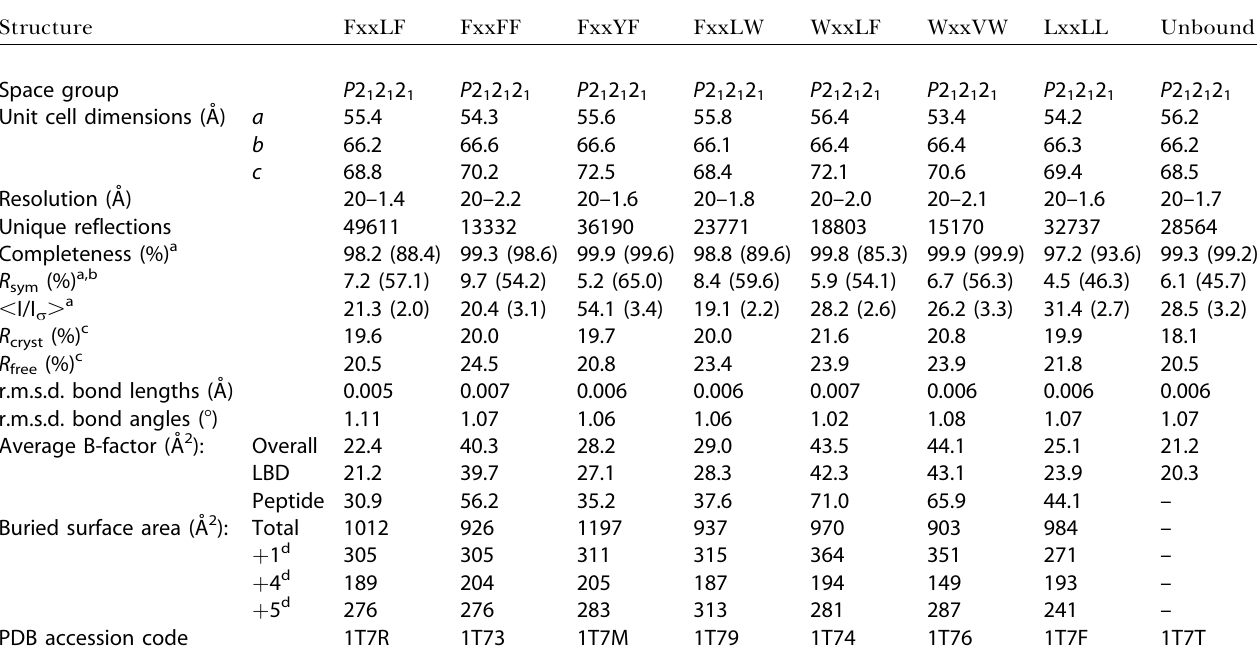
Table 2. Summary of Structures and Crystallographic Statistics